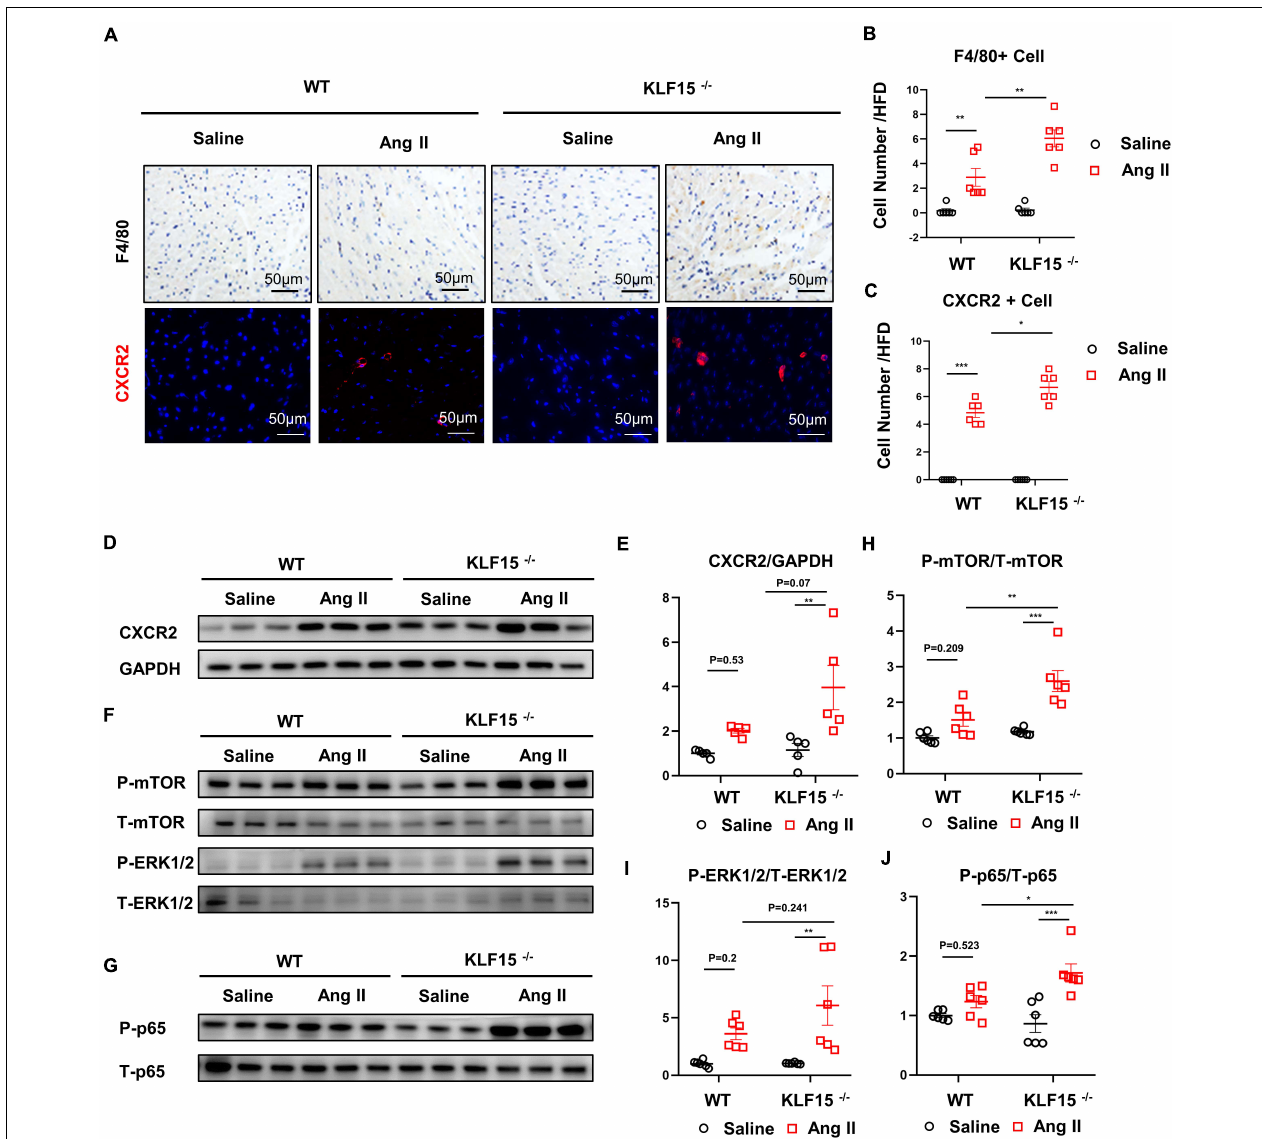
FIGURE 3 | KLF15 regulated CXCR2 -mediated inflammatory cell infiltration and downstream signal. WT and KO mice were infused with saline or Ang II for 14 days. (A) Representative immunohistology and immunofluorescence image of F4/80, CXCR2 positive cell in heart. (B,C) Quantification analysis of F4/80, CXCR2 positive cell infiltration in mice heart. (D,E) Western Blot and quantification analysis of CXCR2 /GAPDH. (F–J) Western Blot and quantification analysis of P-mTOR/T-mTOR, P-ERK1/2/T-ERK1/2 and P-p65/T-p65 of mice heart. * P < 0.05, ** P < 0.01, and *** P <